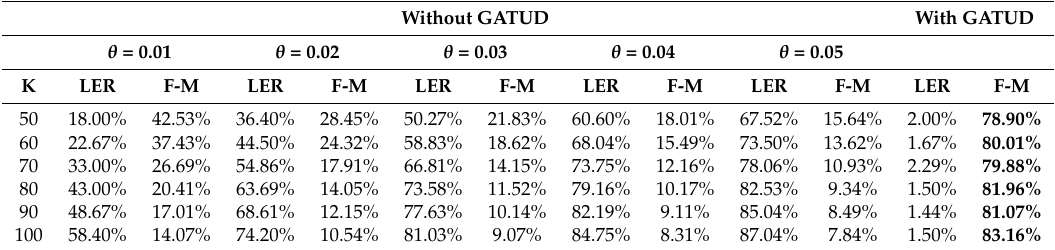
Table 22. The detection accuracy of k -means clustering algorithm with/without GATUD on MORD. Without GATUD With GATUD θ = 0.01